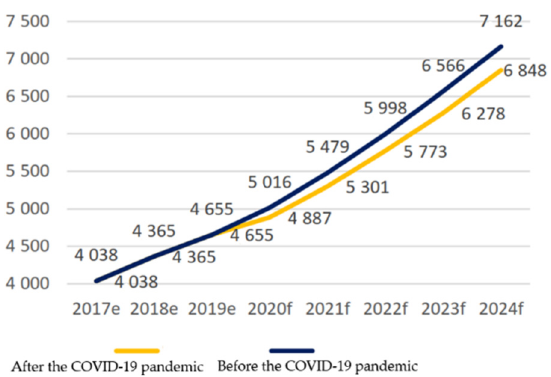
Figure 1. Household disposable income in Vietnam (Unit: USD).